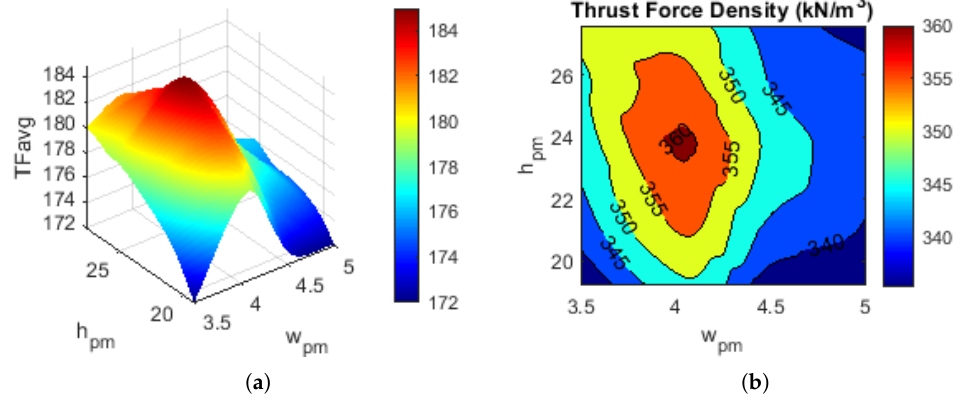
Figure 9. Influence of w pm and h pm on ( a ) TF avg ( b ) TFD